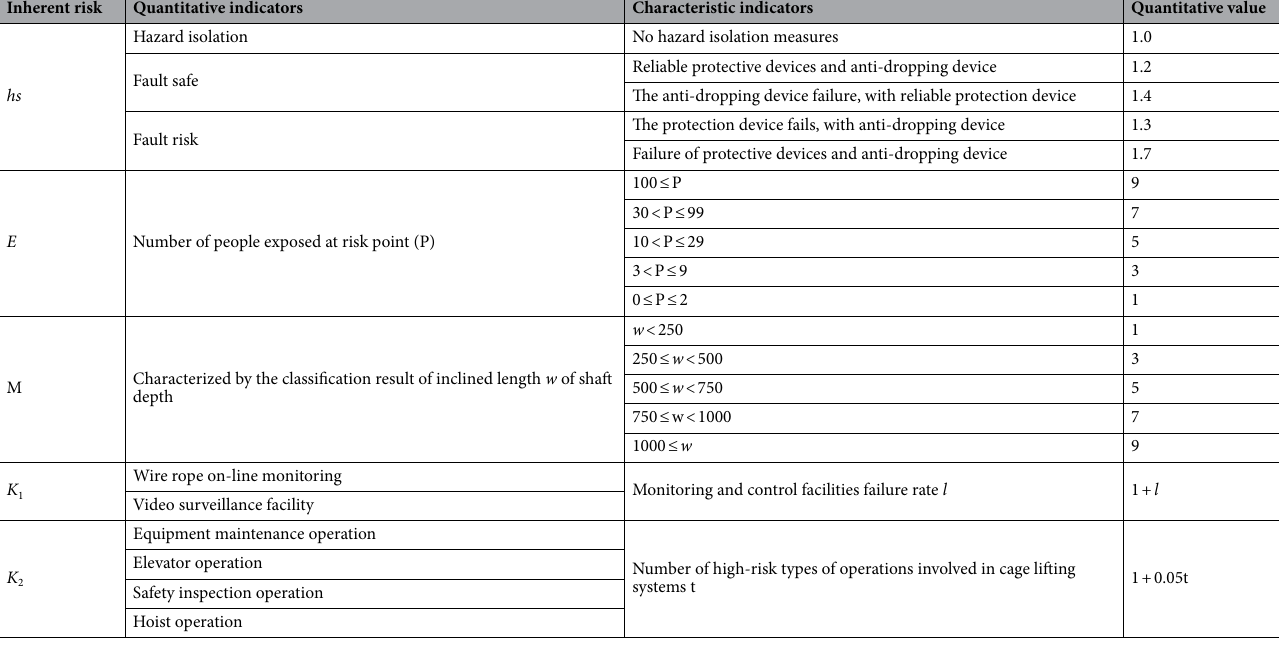
Table 1. Cage fall accident risk